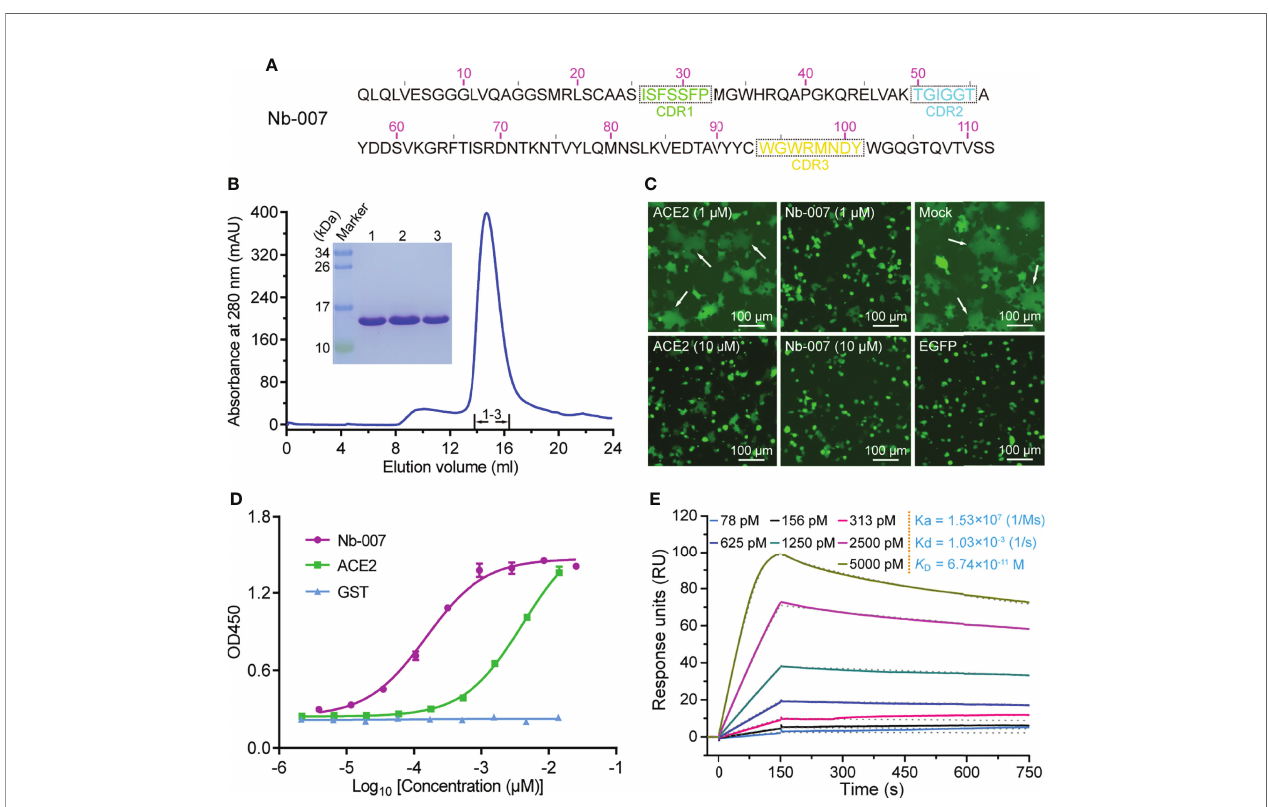
FIGURE 1 | Identi fi cation and functional characterization of Nb-007 as a neutralizing nanobody with high binding af fi nity towards SARS-CoV-2 S-RBD. (A) The amino-acid sequence of Nb-007. The three complementarity-determining regions (CDRs) are labelled with dashed boxes. (B) Characterization of the solution behavior of Nb-007 by gel fi ltration chromatography. The inset fi gure shows the SDS-PAGE analyses of the pooled samples. (C) Inhibition of the SARS-CoV-2 S- protein-mediated syncytium-formation in the presence of Nb-007 or ACE2 at the indicated concentrations. Mock: cell-cell fusion induced by mixing HEK293T-ACE2 and HEK293T-S/EGFP cells without the addition of either the nanobody or ACE2. EGFP: only 293T-S/EGFP cells. The representative syncytia are marked with white arrows. Scale bar equals 100 µm. (D) The multi-concentration ELISA-binding pro fi le between SARS-CoV-2 S-RBD and the indicated proteins (Nb-007, ACE2 and GST). The OD450 emissions are plotted as curves. Each error bar represents the mean ± SD from three independent experiences. (E) Interaction between Nb-007 and SARS-CoV-2 S-RBD detected via SPR. The recorded binding pro fi les and calculated kinetic parameters are